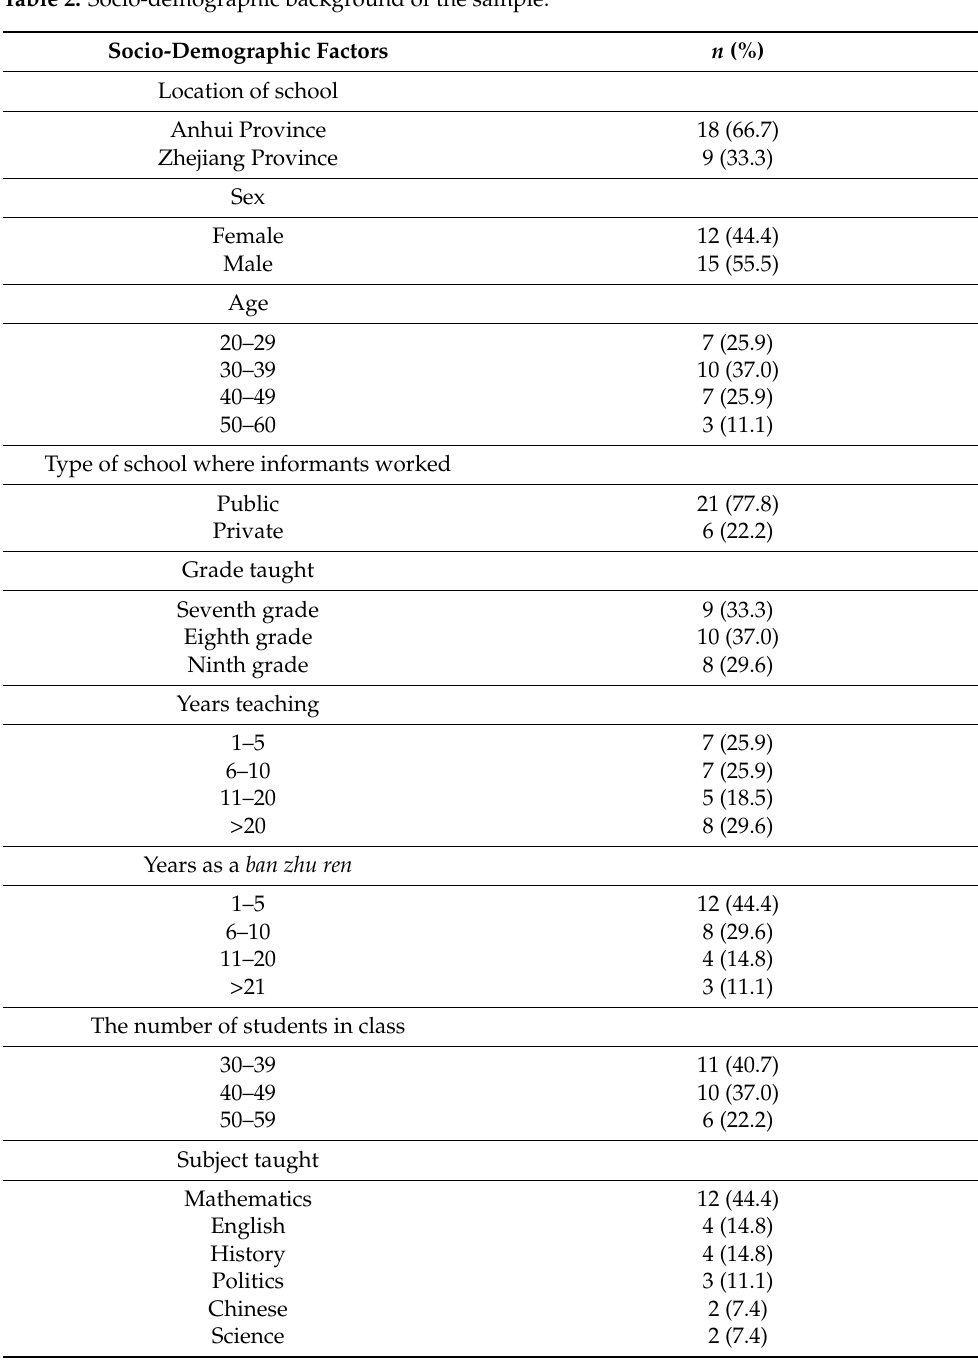
Table 2. Socio-demographic background of the